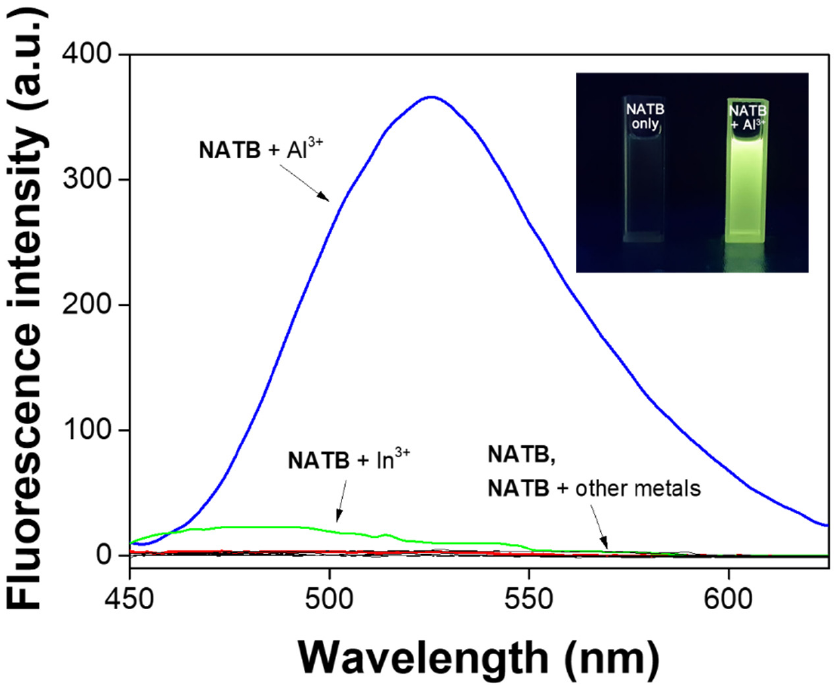
Figure 1. Fluorescence changes of NATB (30 µ M) with a variety of cations (1.5 equiv) in MeOH. Photograph: the fluorescent images of NATB and NATB- Al 3+ ( λ ex : 358 nm).